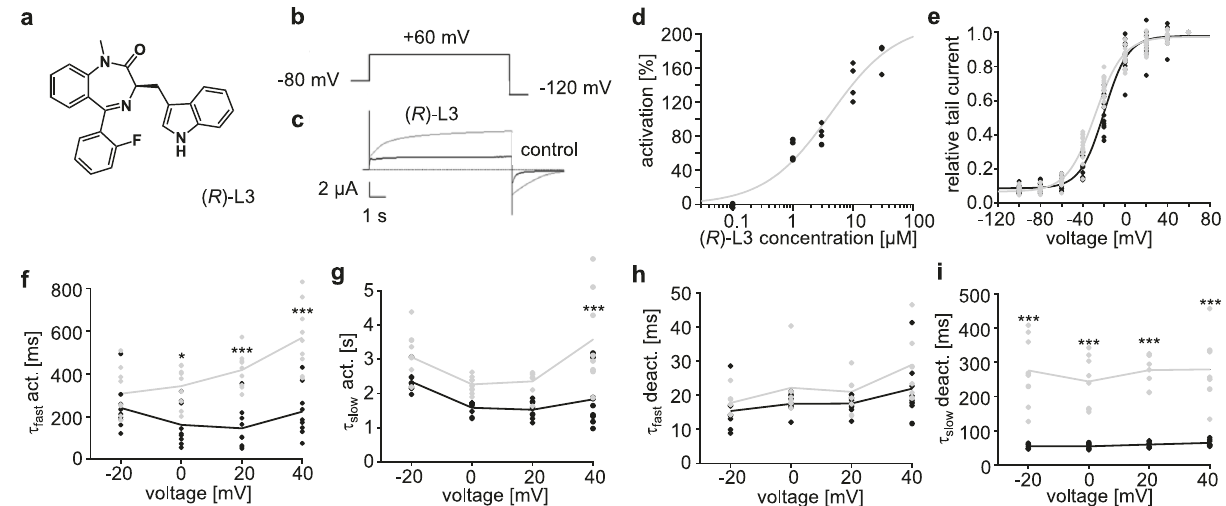
Fig. 1 ( R )-L3 activates and slows the rates of activation and deactivation of hK v 7.1 channels expressed in Xenopus oocytes. a Chemical structure of ( R )- L3. b Pulse sequences for voltage-clamp experiments. c Effect of 1 µ M ( R )-L3 on hK v 7.1 currents, recorded in an oocyte by a 7-s pulse to potentials of − 100 mV to + 60 mV from a holding potential of − 80 mV. Currents were recorded in control solution containing 0.1% DMSO followed by perfusion with 1 μ M ( R )-L3 containing solution. d Dose – response curve for ( R )-L3 from hK v 7.1 expressing oocytes at + 40 mV test voltage. Each concentration was applied to four independent oocytes ( n = 20) e Voltage dependence of current activation in the absence (black; n = 13) and presence of ( R )-L3 (gray; n = 15) determined from peak tail currents measured at − 120 mV. Currents were normalized to the peak tail currents elicited after a pulse to + 40 mV. f – i Kinetics were evaluated in both absence (black; ctrl) and presence (gray; + ( R )-L3) of 1 µ M ( R )-L3 and fi tted by a two-component exponential function. Time constants are calculated for individual oocytes and given for fast ( f ; n = 9 for both conditions) and for slow ( g ; n = 9 for ctrl, n = 8 for + ( R )-L3) component of K v 7.1 activation as well as for fast ( h ; n = 8 for ctrl, n = 6 for + ( R )-L3) and for slow ( i ; n = 7 for ctrl, n = 8 for + ( R )-L3)) component of K v 7.1 deactivation. Signi fi cance of mean differences was analyzed by one-way ANOVA and posthoc mean comparison Tukey test (* p < 0.05, *** p < 0.001).